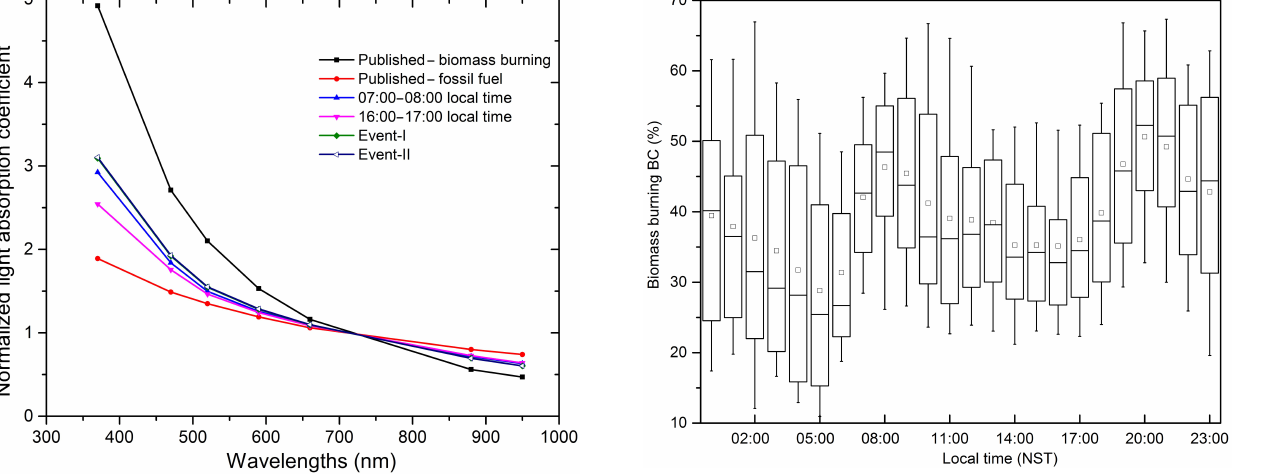
Figure 11. Comparison of normalized spectral light absorption co- efficients obtained during the prime cooking (07:00–08:00 LT) and non-cooking time (16:00–17:00LT) at Lumbini with published data from Kirchstetter et al. (2004).